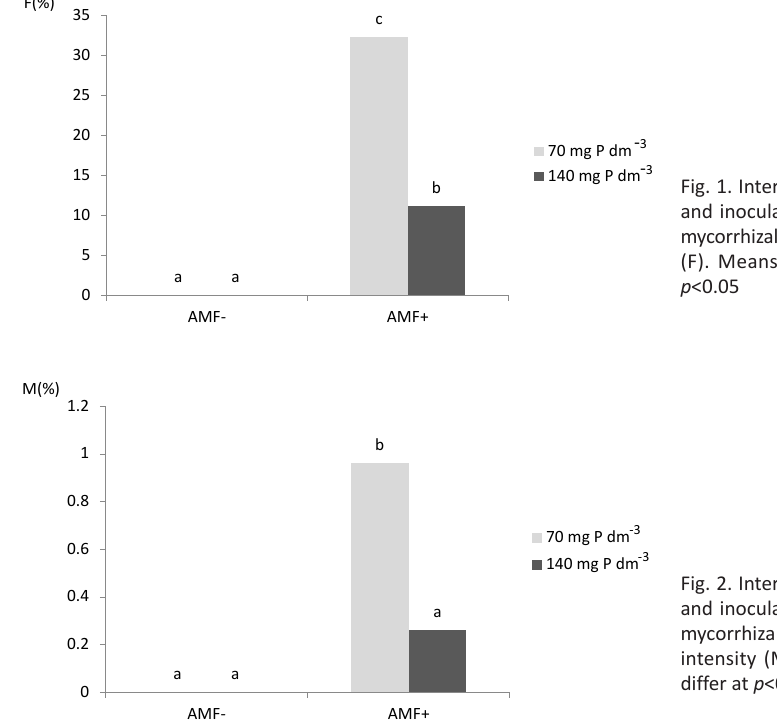
Fig. 2. Interaction between the level of phosphorus and inoculation or non-inoculation with arbuscular mycorrhizal fungi (AMF) on the relative mycorrhizal intensity (M). Means followed by different letters differ at p